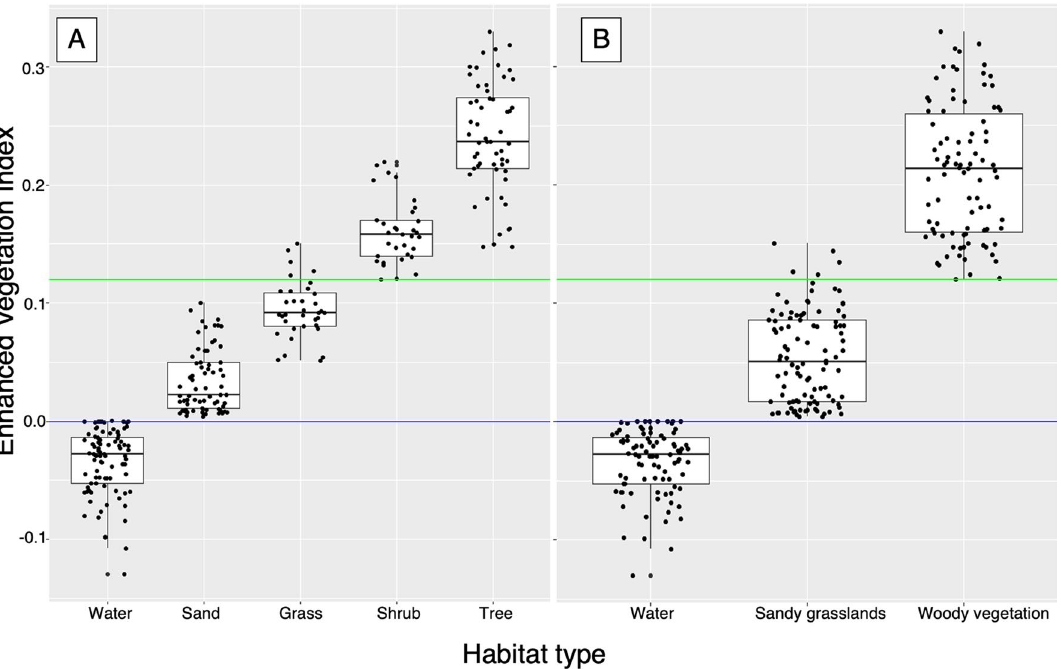
Figure 3. Assessment of the classification accuracy of EVI from 1988 to 2019. It revealed that water (EVI < 0, below the blue line) to have been classified most accurately. (A) Supervised classification using five habitat types. (B) Supervised classification after merging habitat types in three category. The sand and grass class was merged into one class of ‘sandy grasslands (0 < EVI < 0.13, in between blue and green line), while shrubs and trees were merged into ‘woody vegetation class (EVI > 0.13, above the green